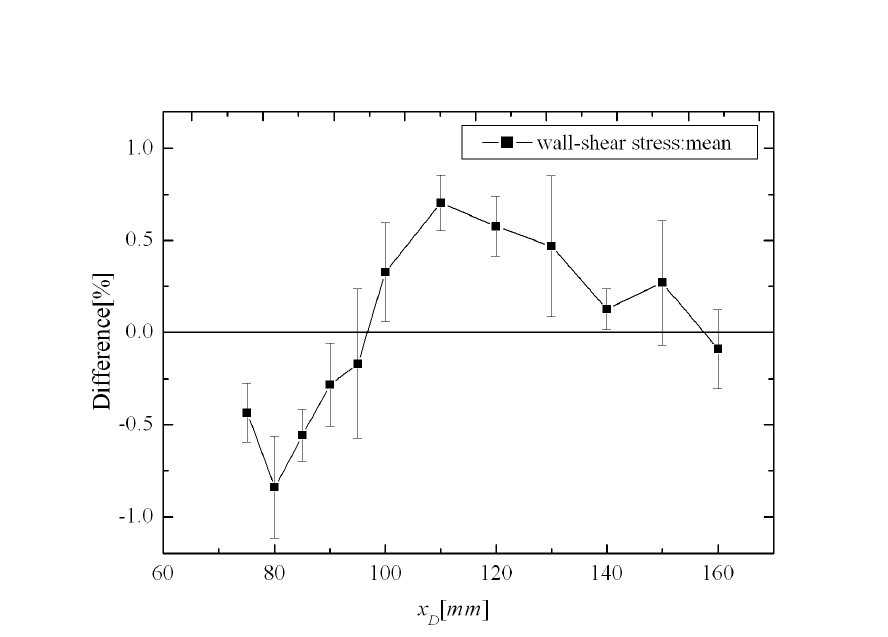
Fig.12 Effect of PSJA in different x